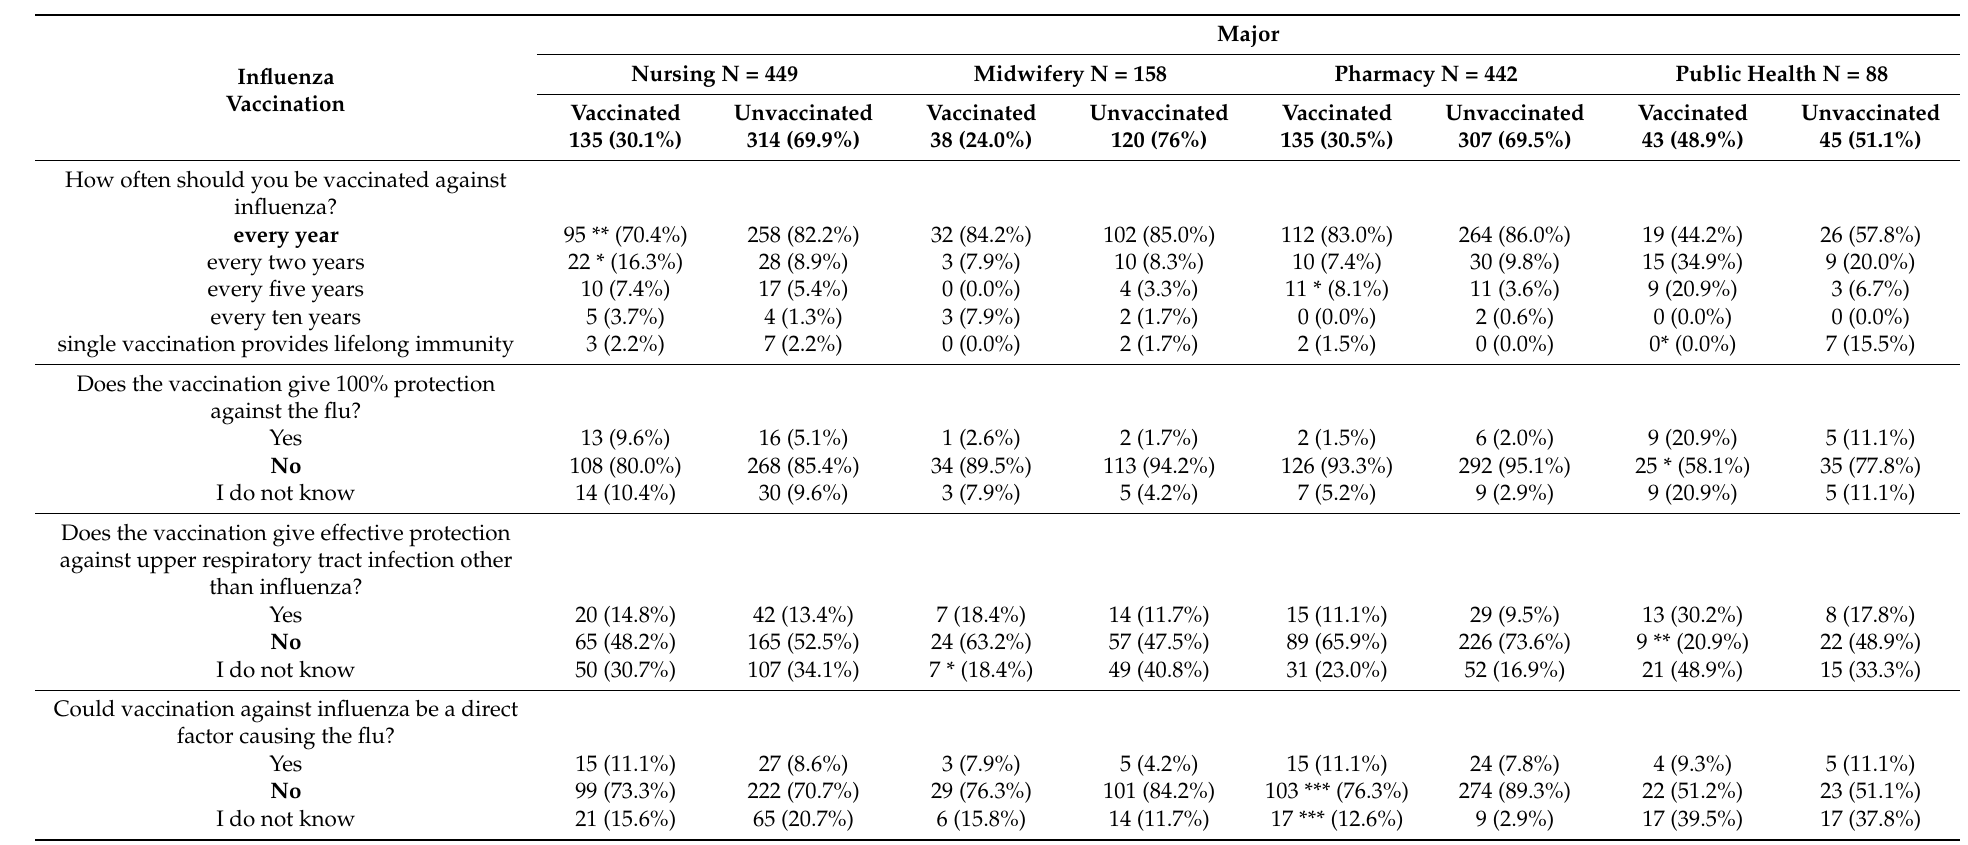
Table 2. Knowledge of the vaccination among vaccinated and unvaccinated students from four majors: Nursing, Midwifery, Pharmacy, and Public health. Major Nursing N = 449 Midwifery N = 158 Pharmacy N = 442 Public Health N = 88 Influenza Vaccination Vaccinated Unvaccinated Vaccinated Unvaccinated Vaccinated Unvaccinated Vaccinated Unvaccinated 135 (30.1%) 314